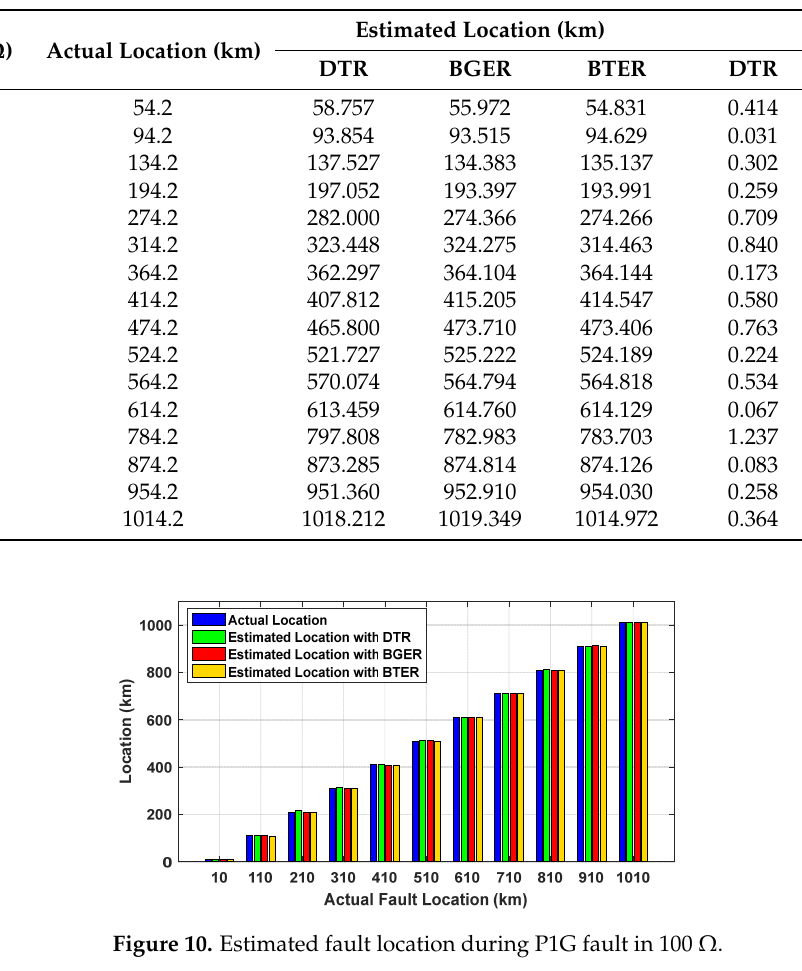
Table 2. Performance Varying Fault Resistance.